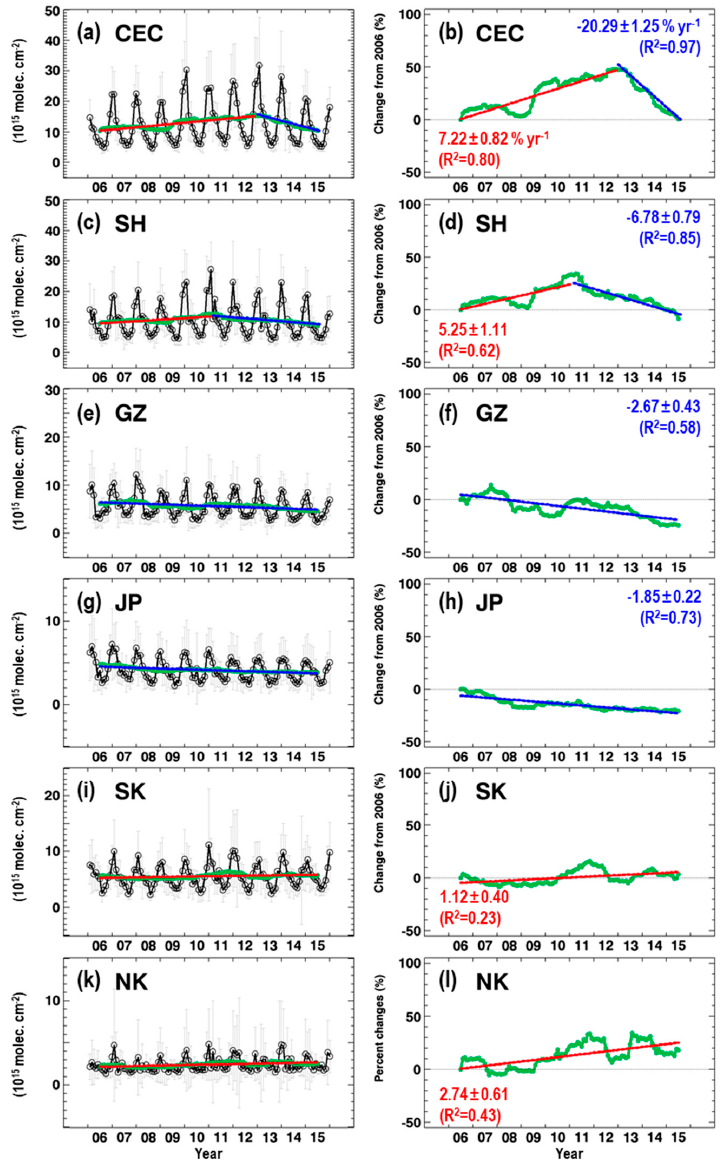
Figure 3. Left panel represents the monthly variations of tropospheric NO 2 columns (10 15 molecules cm − 2 ) over ( a ) Central East China (CEC), ( c ) Shanghai (SH), ( e ) Guangzhou (GZ), ( g ) Japan (JP), ( i ) South Korea (SK), and ( k ) North Korea (NK). Gray error bars in the left panel are 1- σ standard deviations. Here, green circle lines represent the 12-month moving averages. Red and blue lines represent the increase and/or decrease trends, respectively, which are calculated from the 12-month moving averages. The right panel represents relative changes (%) in NO 2 columns from 2006 over ( b ) Central East China (CEC), ( d ) Shanghai (SH), ( f ) Guangzhou (GZ), ( h ) Japan (JP), ( j ) South Korea (SK), and ( l ) North Korea (NK). Others are as in the left panel except for the